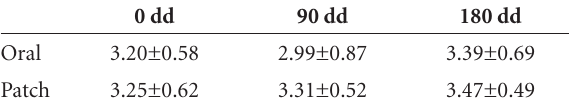
Table 3. Evaluation of AChE levels at three time points